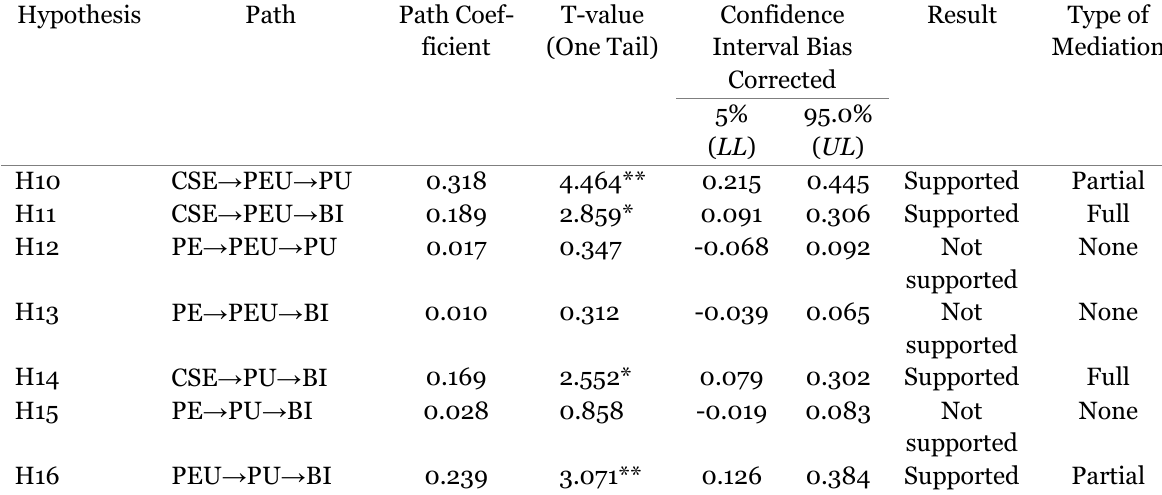
Path Coefficients and Hypotheses Testing (Indirect